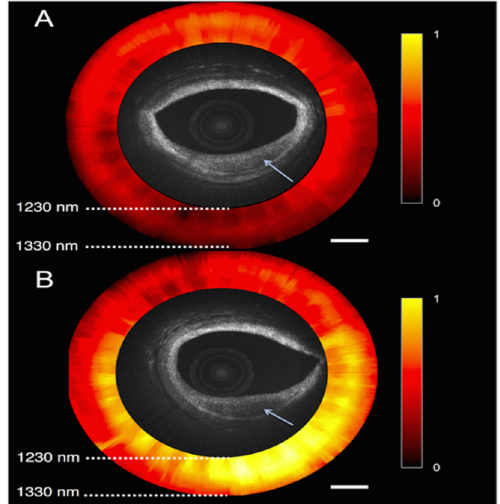
Figure 8. OCT-NIRS images of cadaver coronary artery ex vivo. ( A ) A lesion with low lipid content, characterized by OCT-low backscattering and NIRS-low signal. ( B ) A lipid-rick lesion, characterized by OCT-low backscattering and NIRS-high signal. Reprinted with permission from ref. [97] © The Optical Society.